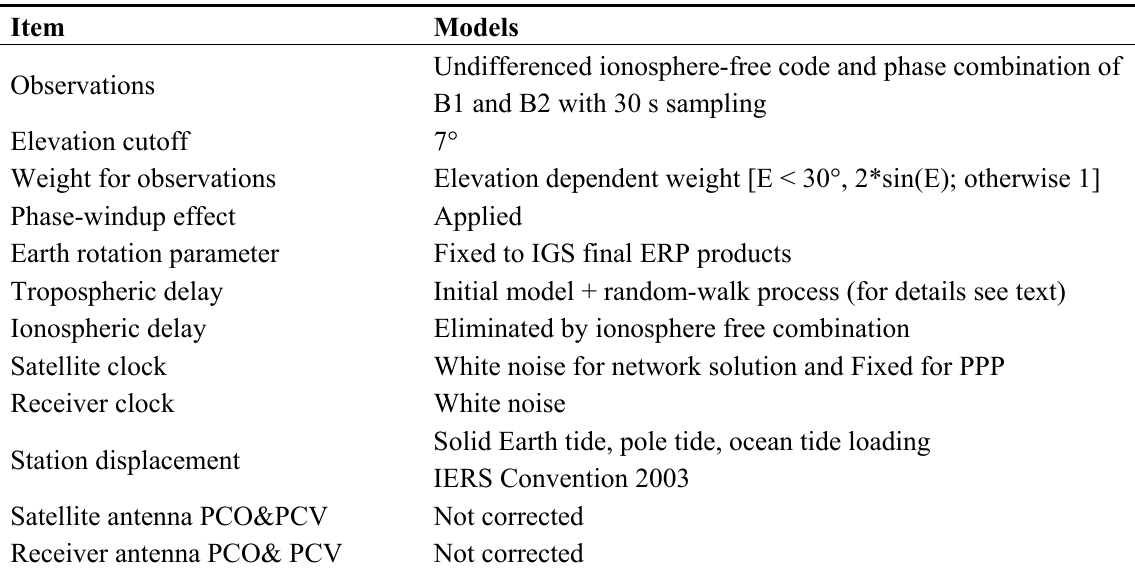
Table 1. Summary of observation models for ZTD